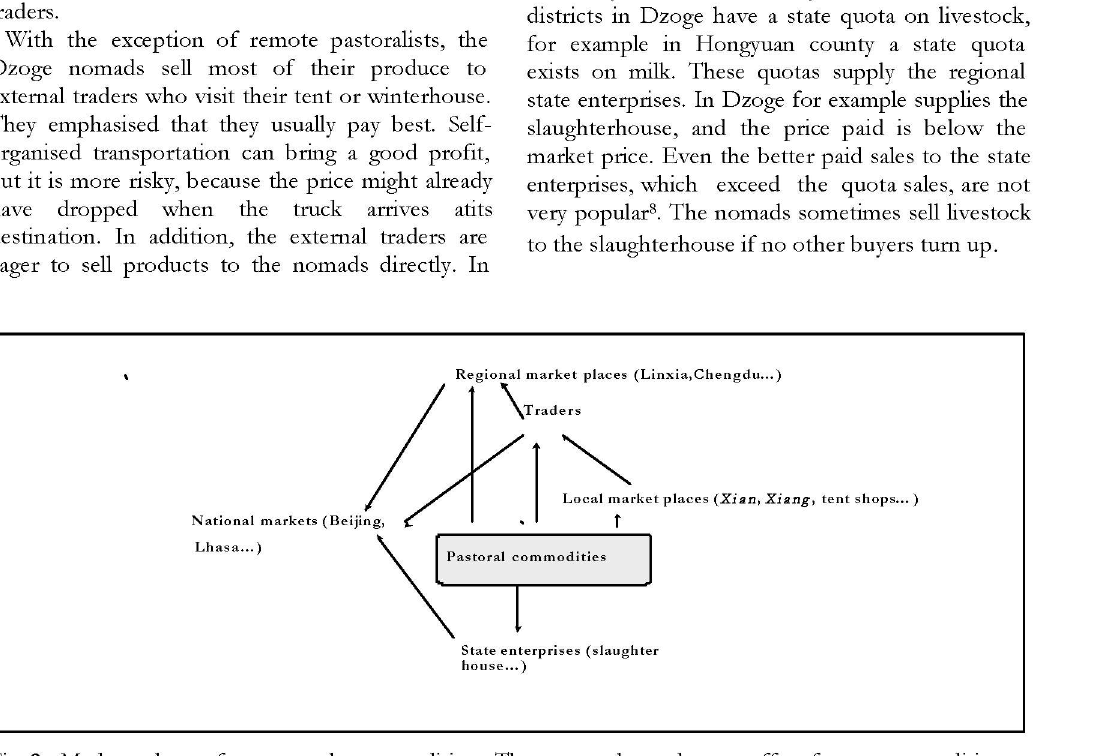
Fig. 2. Market places for pastoral commodities. The pastoral producers offer fome commodities at markets, while others reach the markets via wholesale traders or state